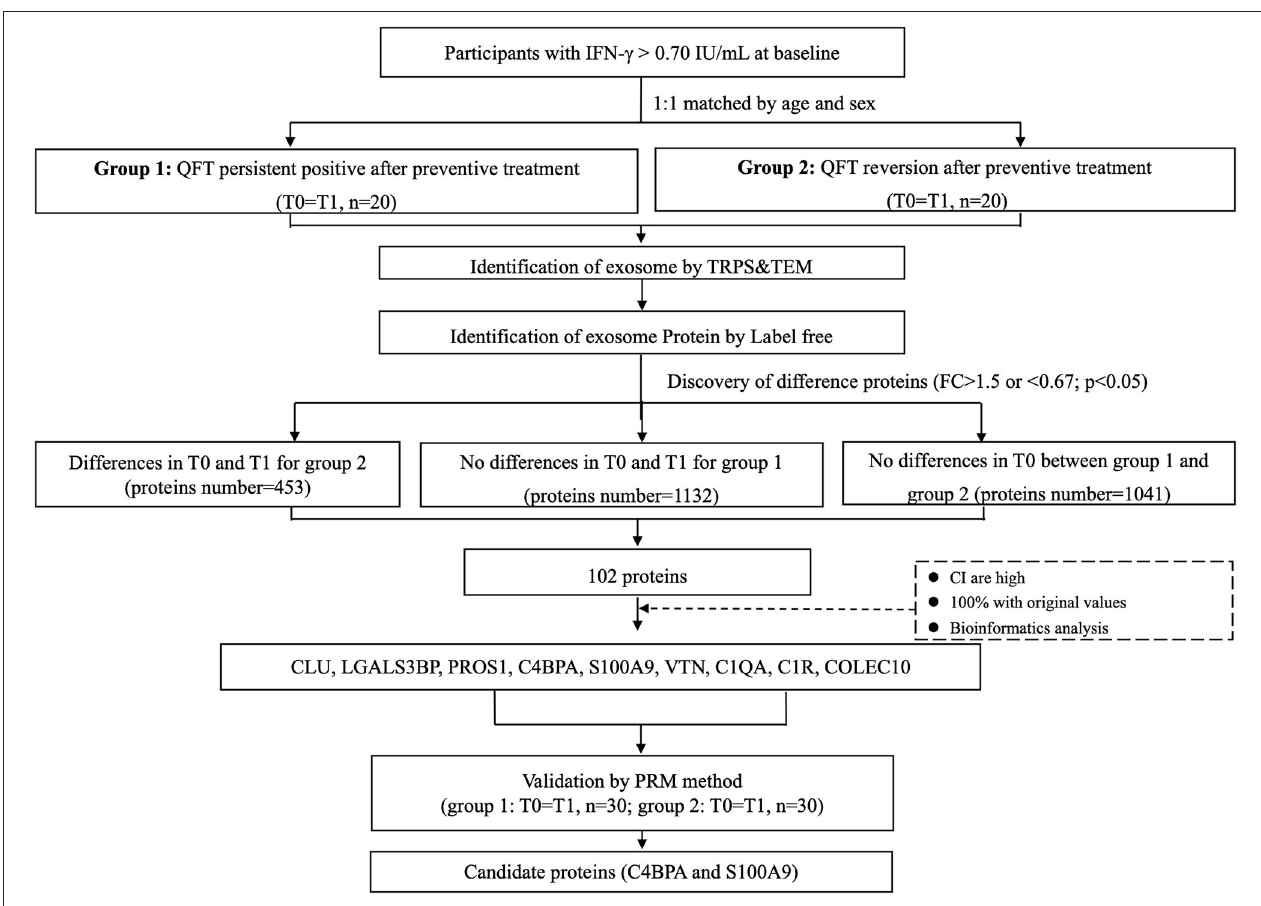
FIGURE 1 | Sample selection and screening process of candidate proteins. Totally, 20 subjects with reversed QFT results after LTBI treatment and 20 age and gender-matched controls with persistent positive QFT results after LTBI treatment were included in the screening set. For each of them, circulating exosomes were collected for proteomic analysis from serums pre- (T0, before LTBI treatment) and post- (T1, after LTBI treatment) LTBI treatment respectively. A total of 102 differentially expressed proteins were identified to be associated with QFT reversion. Among them, 9 downregulated proteins were validated in the verification set ( n = 60, with 120 samples), including CLU, LGALS3BP, PROS1, C4BPA, S100A9, VTN, C1QA, C1R, and COLEC10. Finally, C4BPA and S100A9 were confirmed to be still differentially downregulated (FC < 0.67, p < 0.05). FC, fold change; LTBI, latent tuberculosis infection; QFT, QuantiFERON-TB Gold